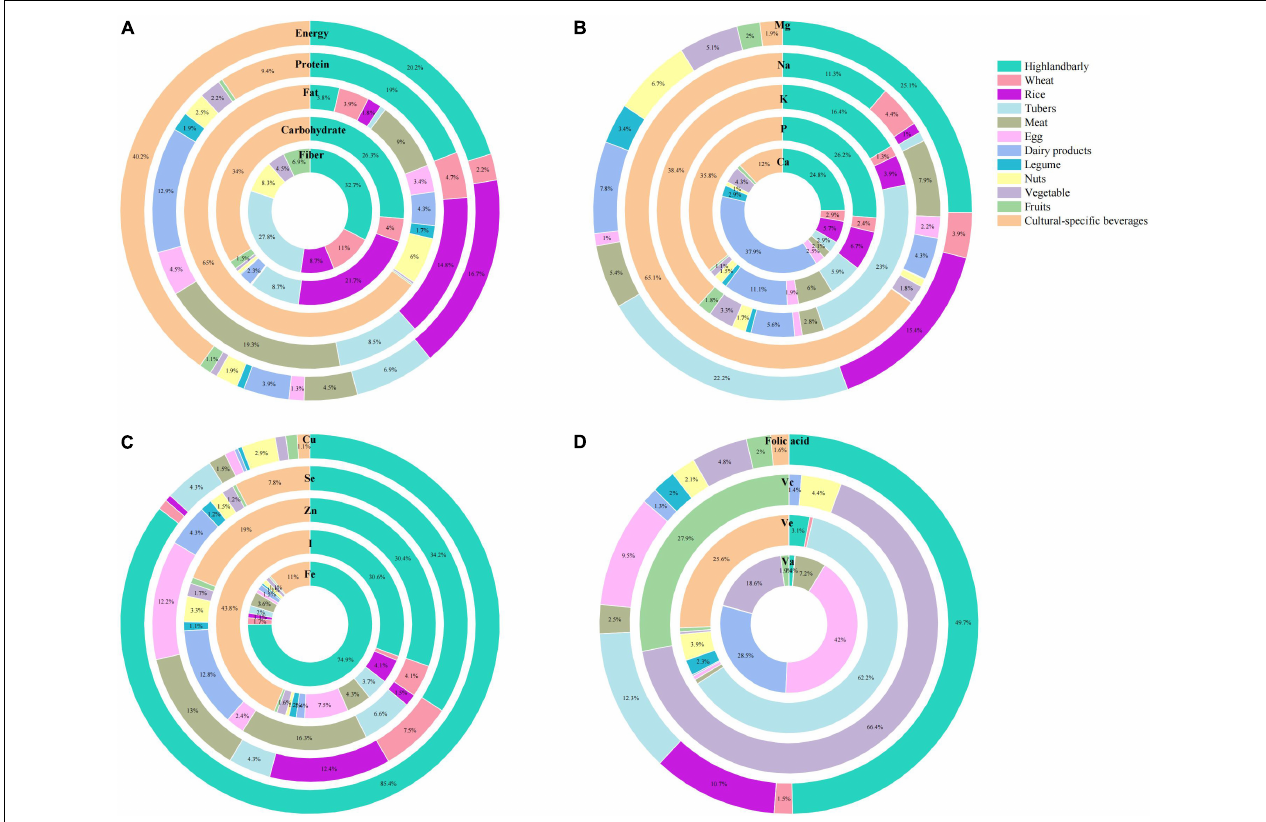
FIGURE 4 | Mean contribution (%) of food groups to dietary intakes of (A) macronutrients (energy, protein, fat, carbohydrate, and fiber), (B) minerals (Ca, P, K, Na, and Mg), (C) micronutrients (Fe, I, Zn, Se, and Cu), and (D) vitamins (Va, Ve, Vc, and folic acid) among Tibetan adults living in agricultural counties of